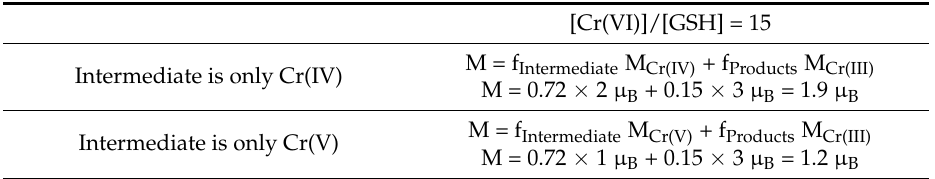
Table 2. Expected saturation magnetic moment in the reaction between Cr(VI) and glutathione in 100 mM glycine at the time when [Intermediate] is at maximum concentration (t top